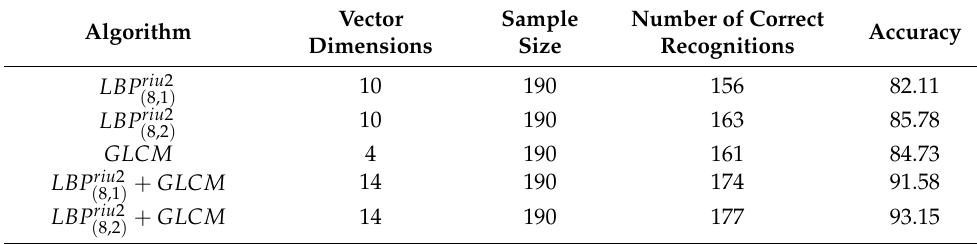
Table 4. Forest fire flame identification